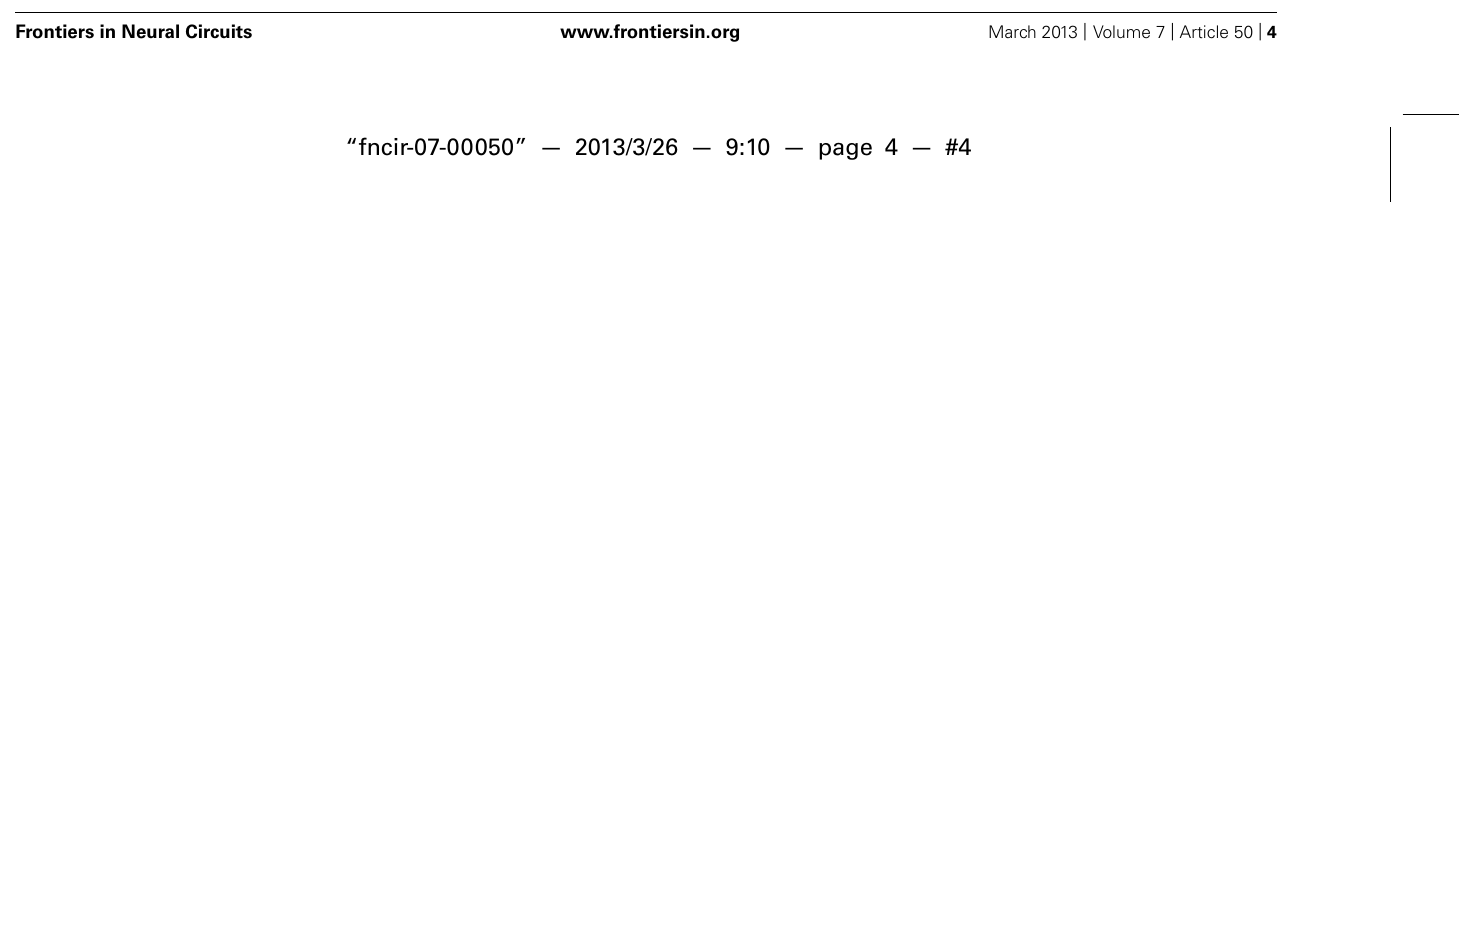
FIGURE 2 | (A) Experimental measurement showing the input–output relationship for the H1-cell under closed-loop conditions (blue) and its least-squares sigmoid fit ( A = 2.68, β = 0.29) (red), obtained from the fly